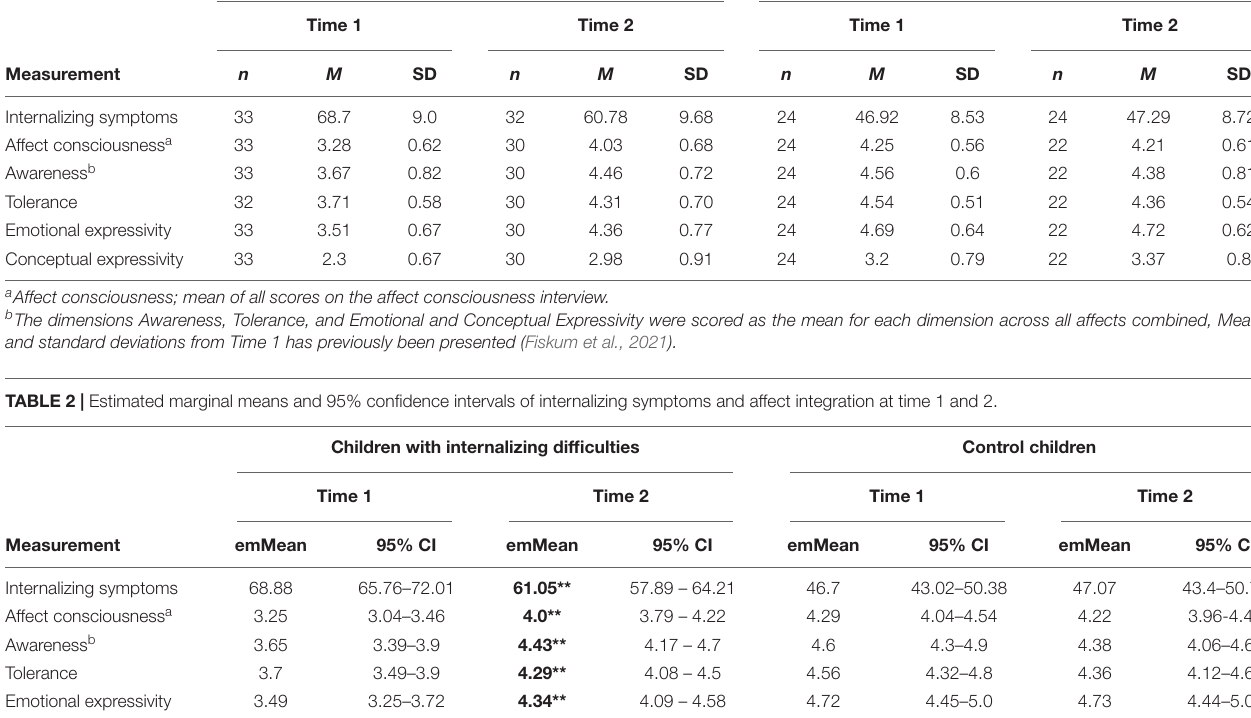
Table displaying estimated marginal means (emMean) for the two groups at time 1 and time 2 along with 95% confidence intervals. a Affect consciousness; mean of all scores on the affect consciousness interview. b The dimensions Awareness, Tolerance, and Emotional and Conceptual Expressivity were scored as the mean for each dimension across all affects combined. ** Indicates that estimated marginal means were significantly different from time 1 to 2 at p > 0.001. Bold font Indicates that estimated marginal means were significantly different from time 1 to